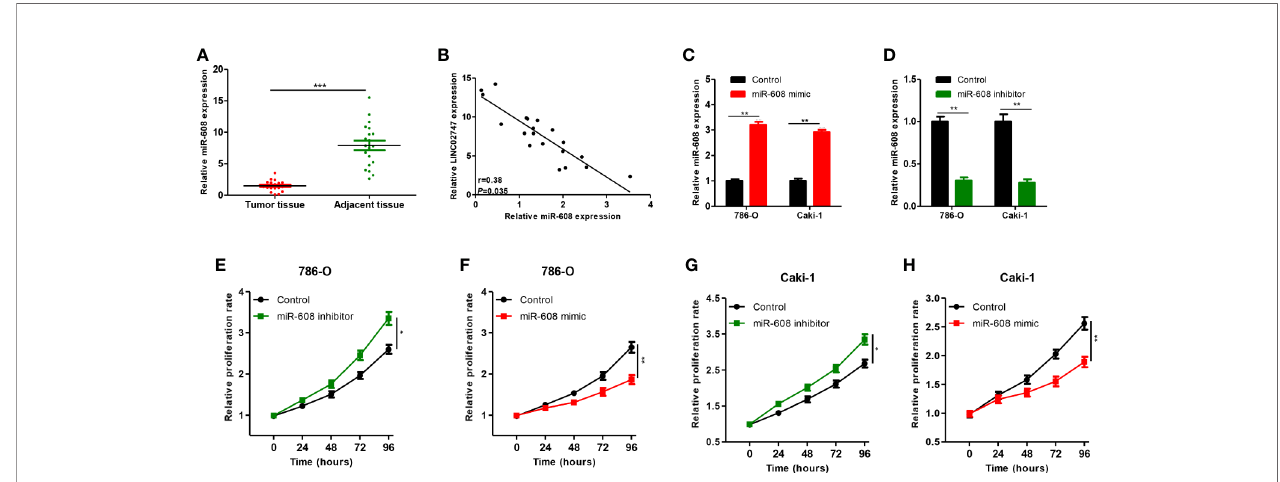
FIGURE 6 | (A) qRT-PCR was used to detect miR-608 expression in 20 pairs of ccRCC tissues and para-carcinoma tissues. (B) The correlation between LINC02747 and miR-608 in 20 ccRCC tissues. Veri fi cation ef fi ciency of overexpressed miR-608 (C) or downregulated miR-608 (D) in 786-O and Caki-1 cell lines by qRT-PCR. After alteration of miR-608 expression, the proliferation of 786-O (E, F) and Caki-1 (G, H) cells was changed. (*** P < 0.001, ** P < 0.01, * P <